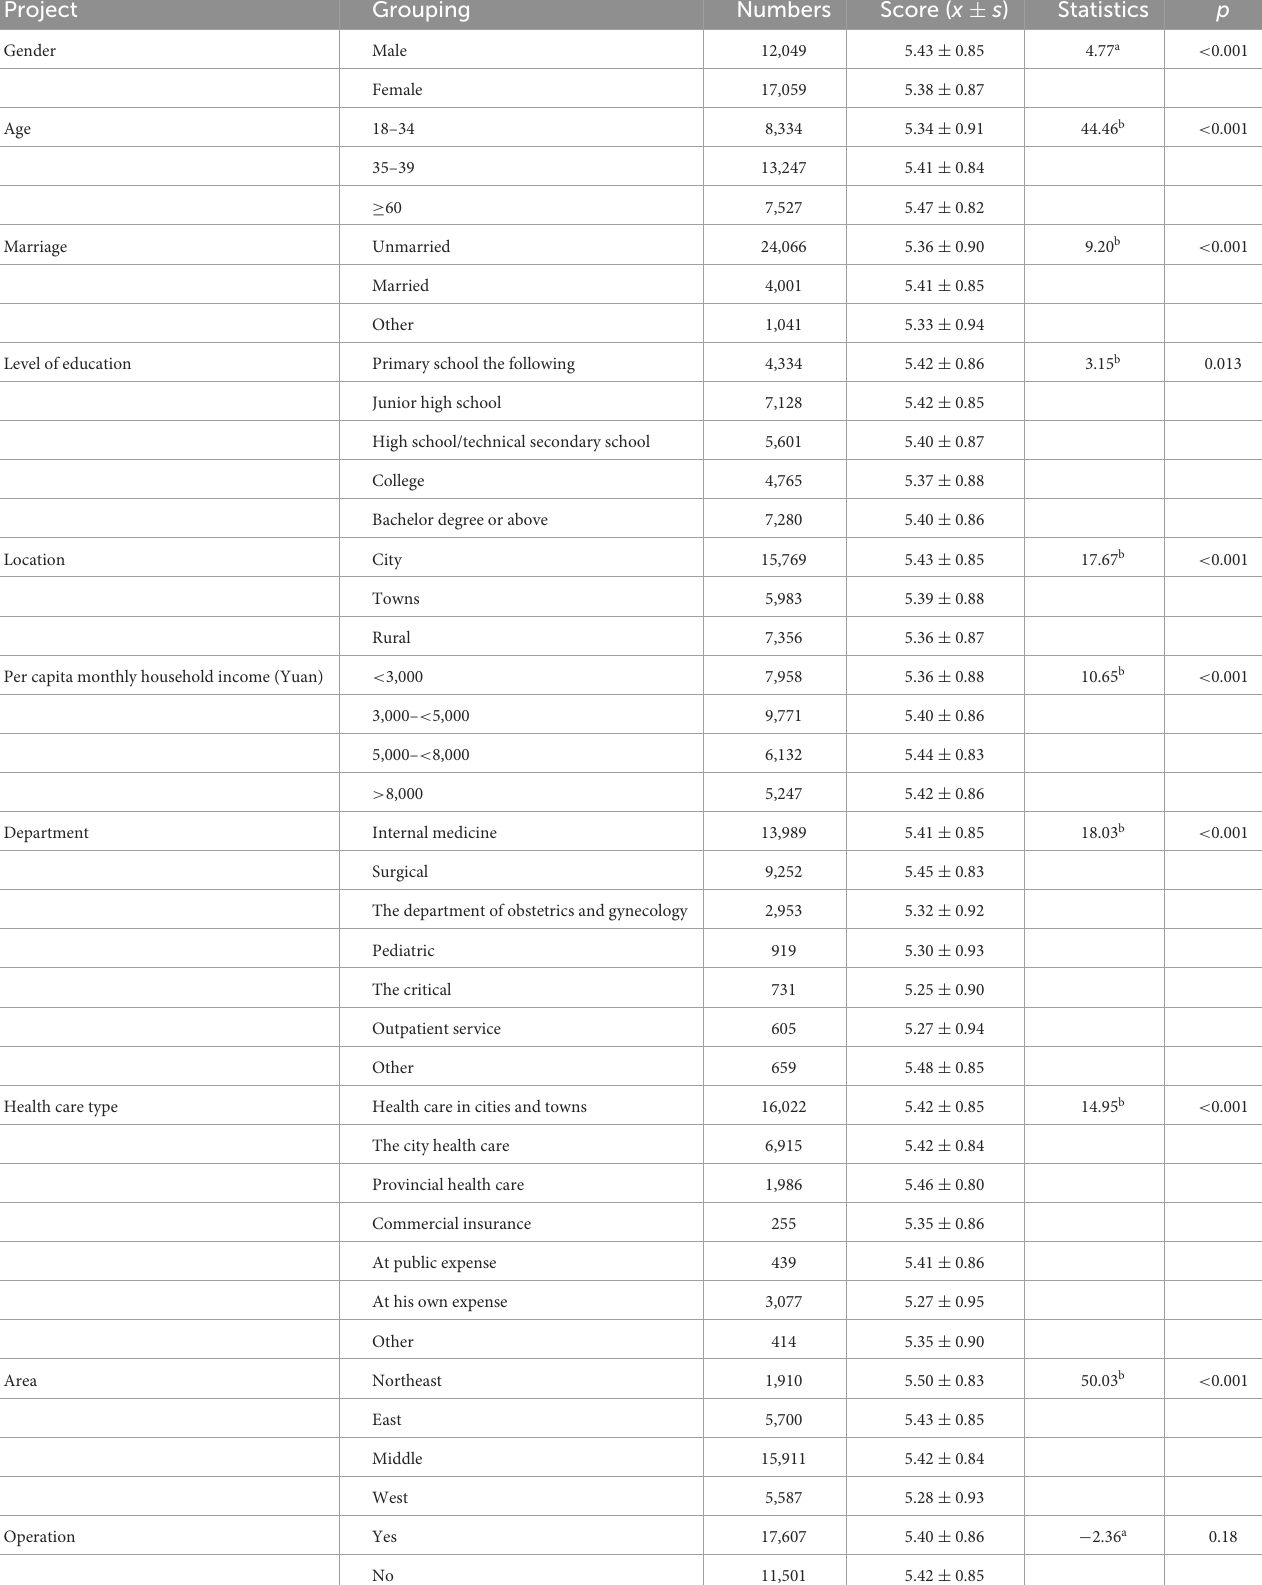
TABLE 1 Comparison of nursing care satisfaction scores of subjects with different demographic